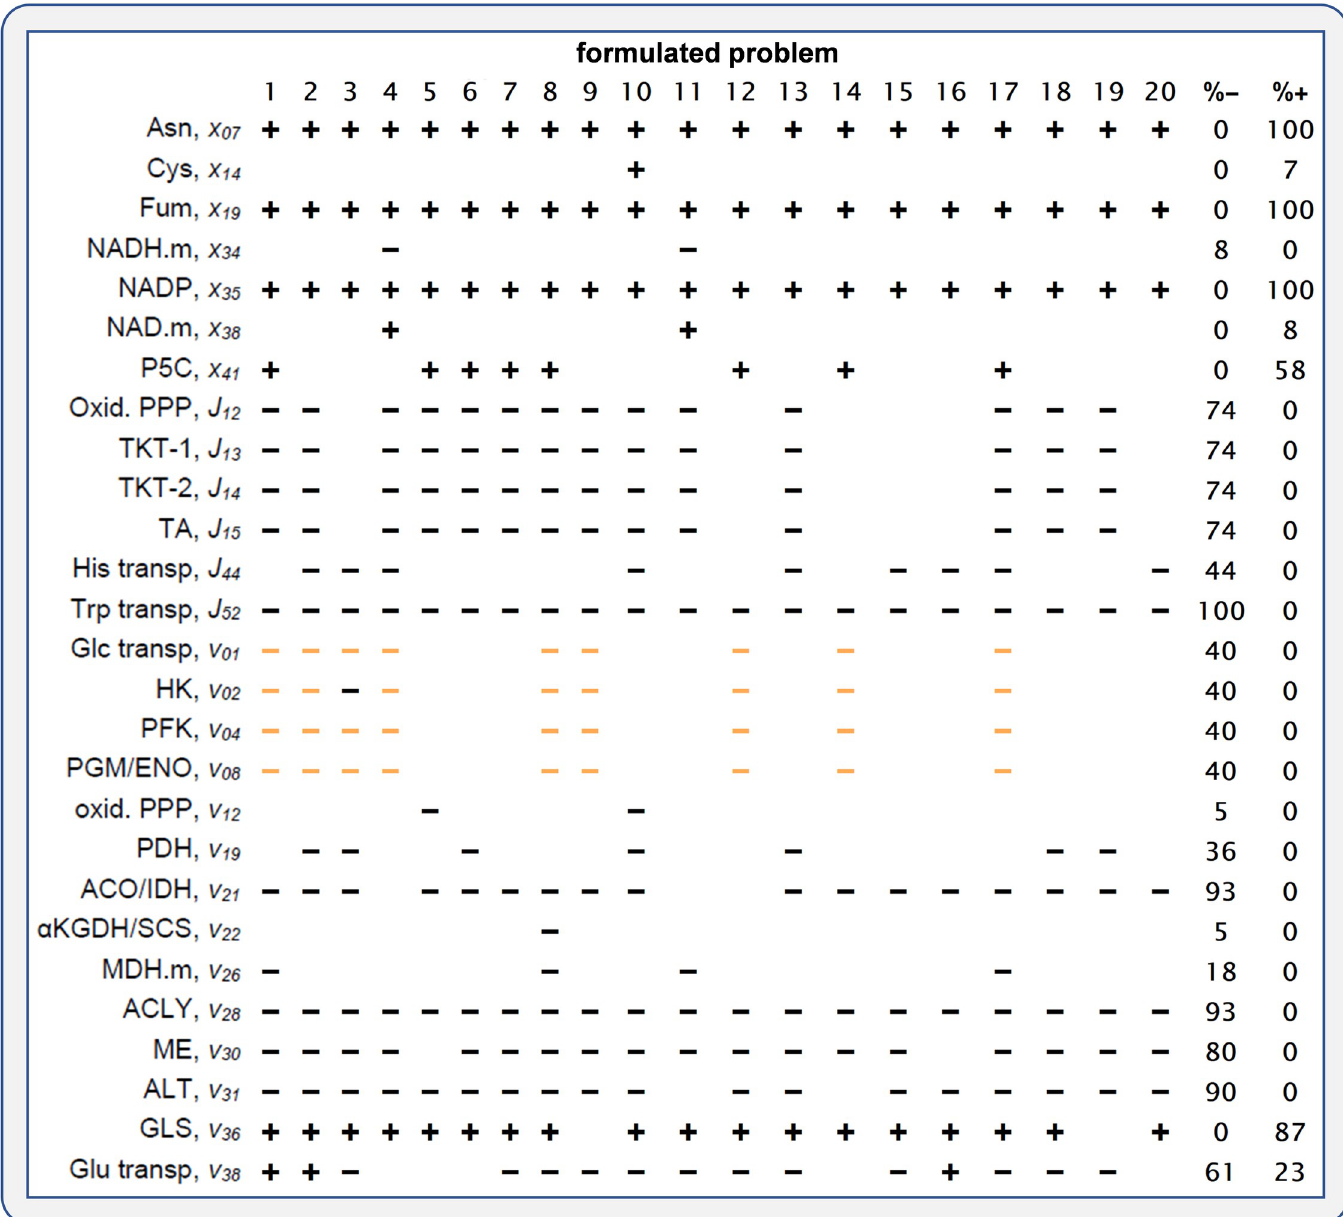
Fig 4. Identification of fixed signs. Cancer-case study. Each column with a number in the top is equivalent to the last column of the table in the panel C (sign) for the glycolysis-case study in Fig 2, for each of the first 20 solved problems of the ensemble of 100 formulated problems. Percentages of negative (% -) and positive (% +) signs refer to the solved problems. The average % gain for all variables and the 100 formulated problems was 29%. In orange, signs dependent on the constraint in Eq (14) that assumes a coordinated regulation changing in parallel the individual activities of Glc transp, HK, PFK, and ENO. See Fig 5 for a numerical summary of the final domains. See Material and Methods for a supplementary description of the network and